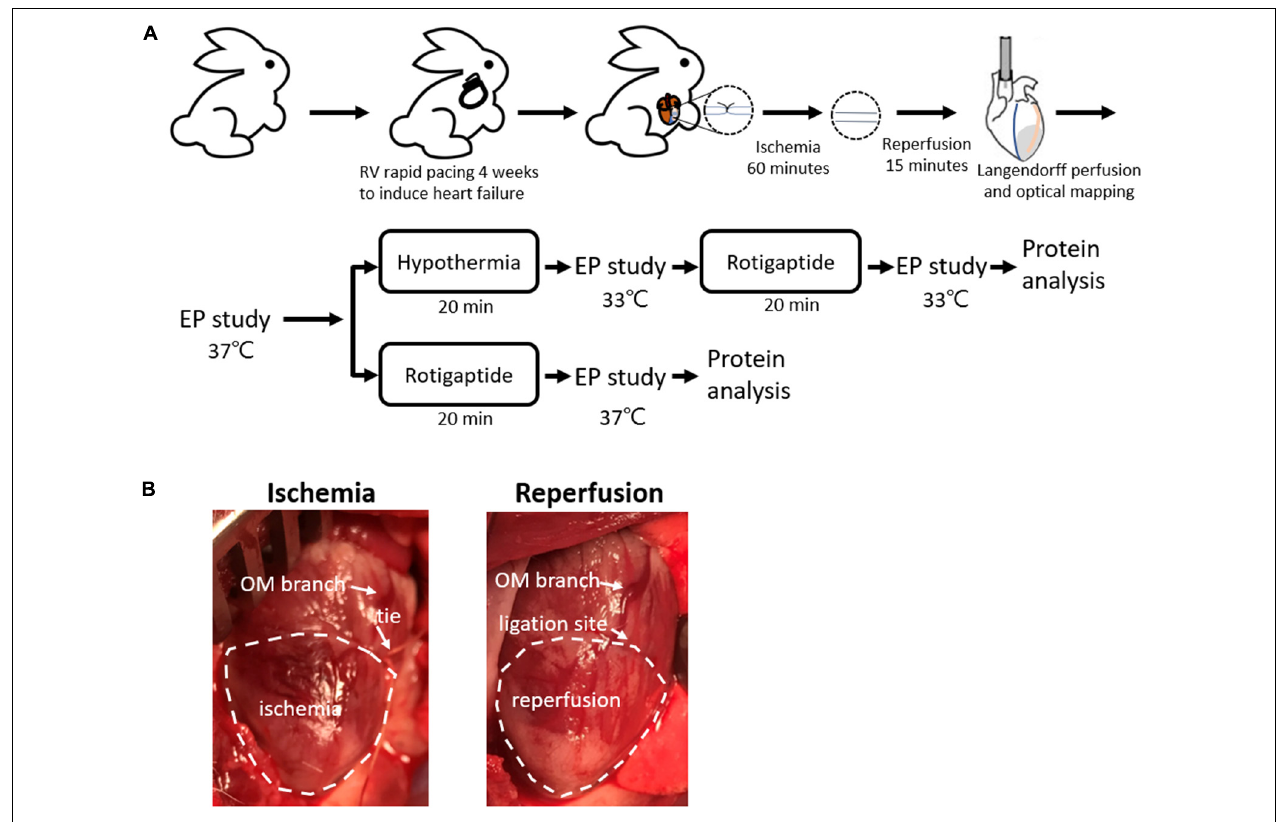
FIGURE 1 | Rabbit ischemia–reperfusion (IR) heart failure model. (A) Protocol diagram. (B) Representative photos of IR model creation. Myocardial ischemia was induced by ligating the obtuse marginal (OM) branch of the left circumflex artery evidenced by darker color of the epicardium in the ischemic zone relative to the intact tissue, which was recovered by releasing the tie. EP, electrophysiological; LAD, left anterior descending artery; RV, right